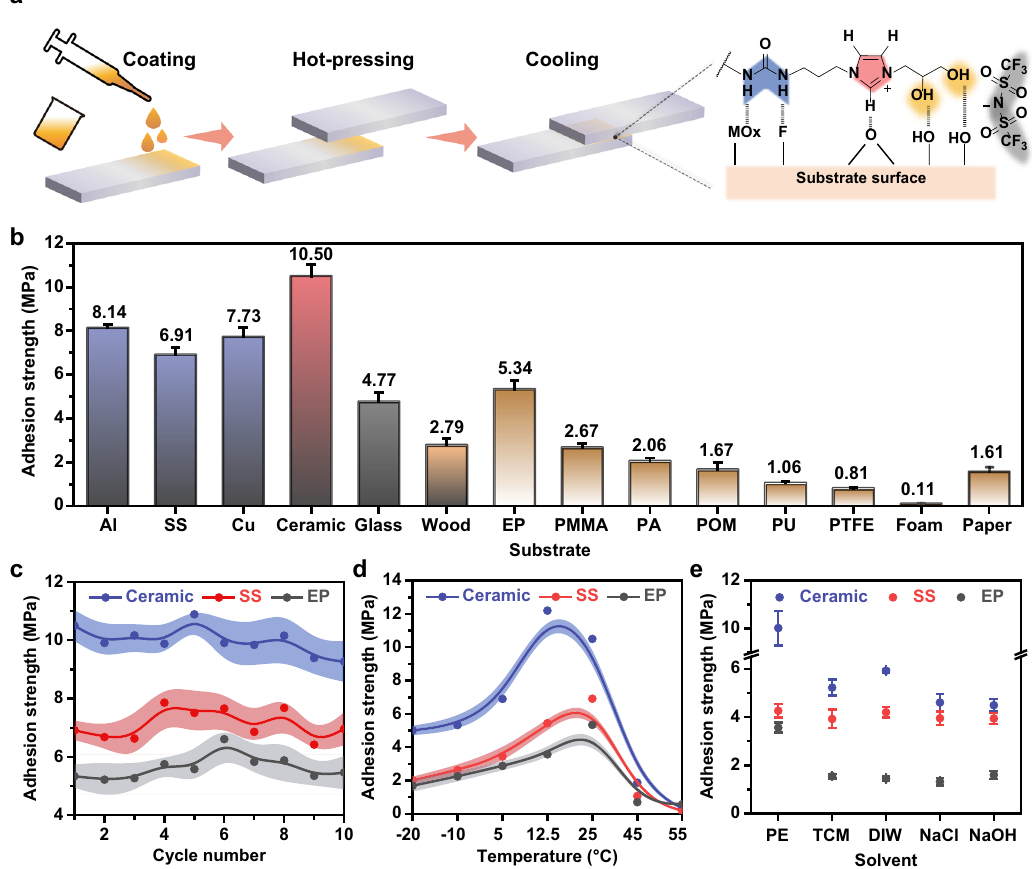
Fig. 2 | Measurements of adhesion strength. a Schematic of the adhesion pro- cedure. b Adhesion strengths of Tri-HT on various substrates under ambient conditions. c Successive cycling tests and d temperature-dependent adhesion strengths of Tri-HT on various substrates. e Adhesion strengths of Tri-HT